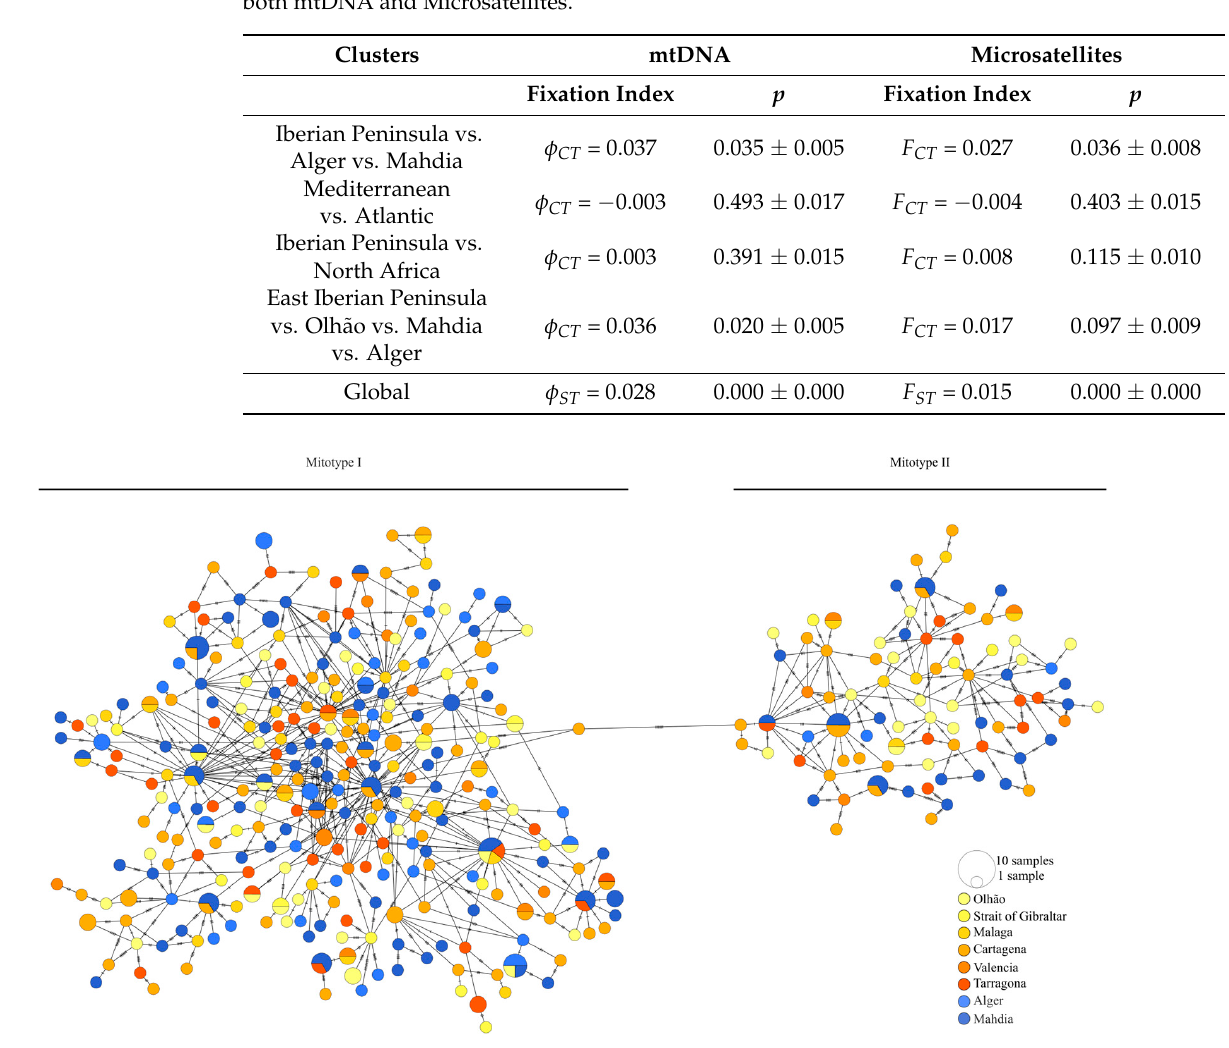
Figure 2. Haplotype network of mtDNA CR marker. Colour pattern represents the location where each haplotype was identified. Each circle represents a single haplotype. The size of the circles indicates the number of individuals with the shared haplotype. Haplotypes were assigned to the previously described mitotype I and II based on their reference sequence